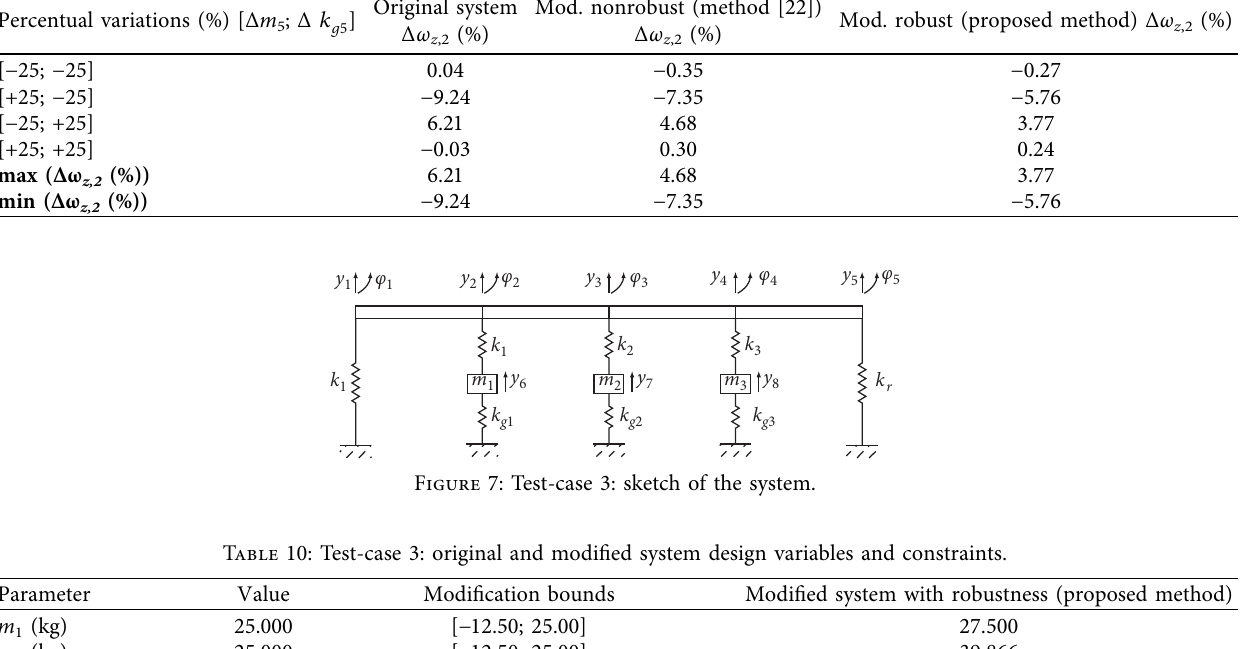
Table 9: Test-case 2: original and modified systems without and with robustness: percentage variation of the second antiresonance frequency of h 12 ( jω ).